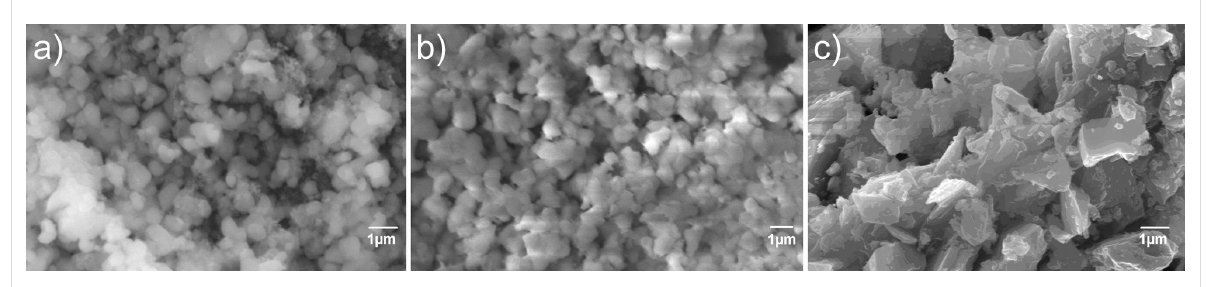
Figure 4: SEM images of fluorophosphate materials a) Li 2 CoPO 4 F/C, b) Li 2 Co 0.9 Mn 0.1 PO 4 F/C, c) Li 2 Co 0.7 Fe 0.3 PO 4 F.